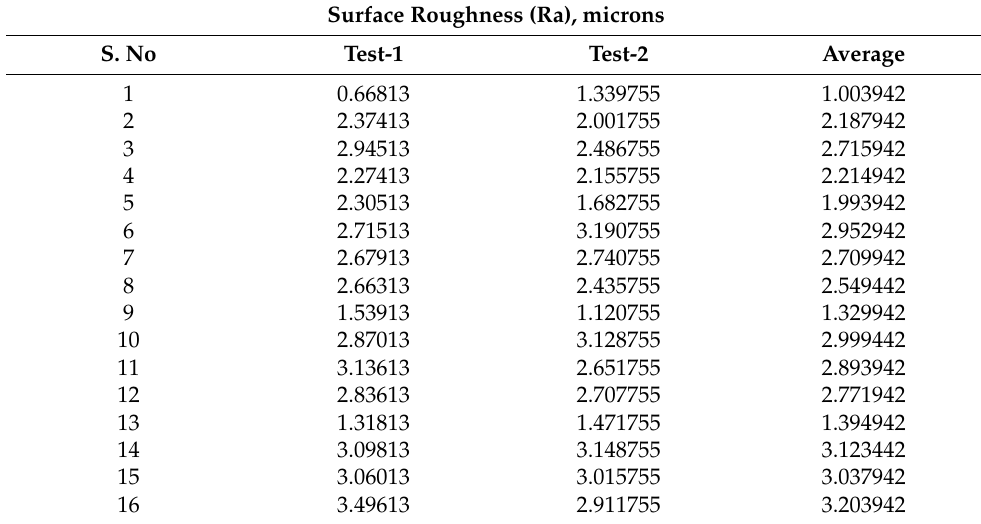
Table 7 points out the surface roughness value of the all specimens efficiently. The minimum and maximum values of surface roughness are 1.003942 and 3.203942 microns. Table 7. Outline of surface roughness results.